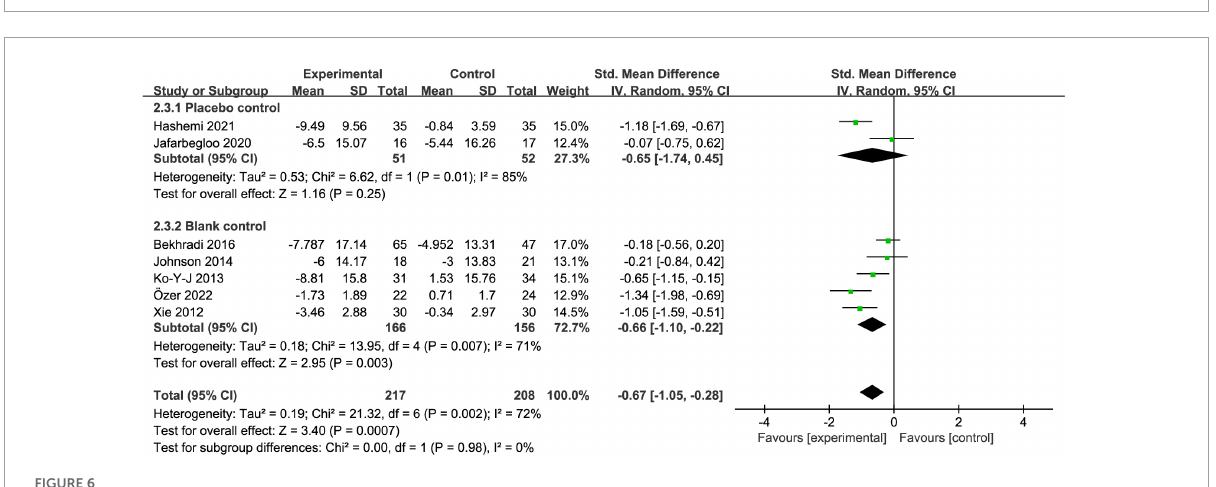
FIGURE5 Subgroup analysis of essential oil devices.